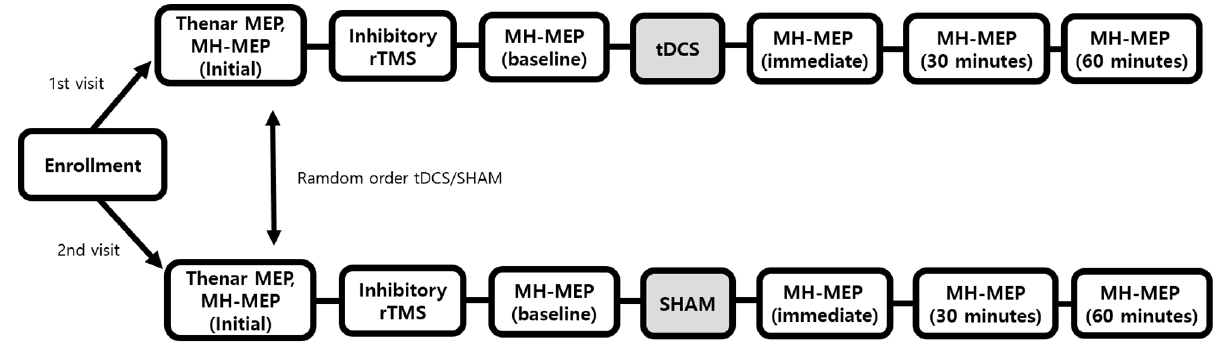
Figure 1. Flowchart of the participants. Abbreviation: MEP: motor-evoked potentials, MH-MEP: mylohyoid motor-evoked potentials, rTMS: repetitive transcranial magnetic stimulation, tDCS: transcranial direct current stimulation.